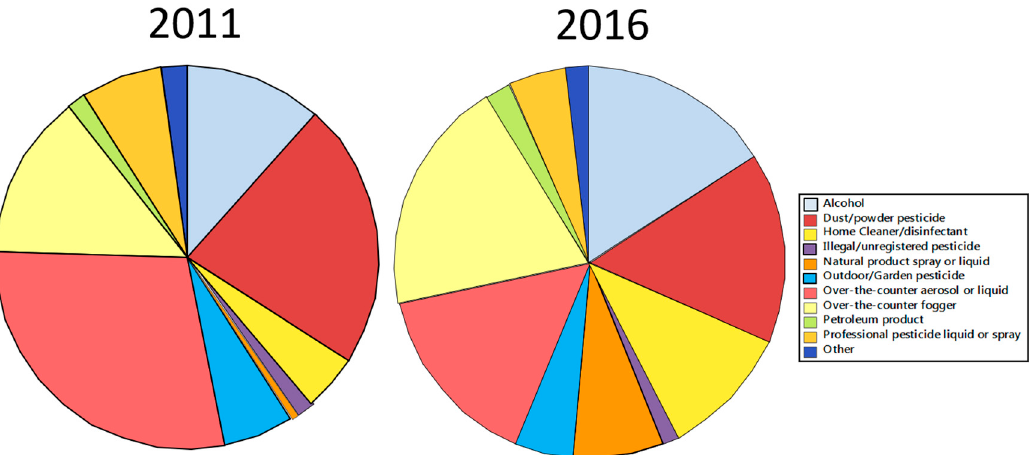
Figure 9. Proportion of products misused by residents in 2011 and 2016.